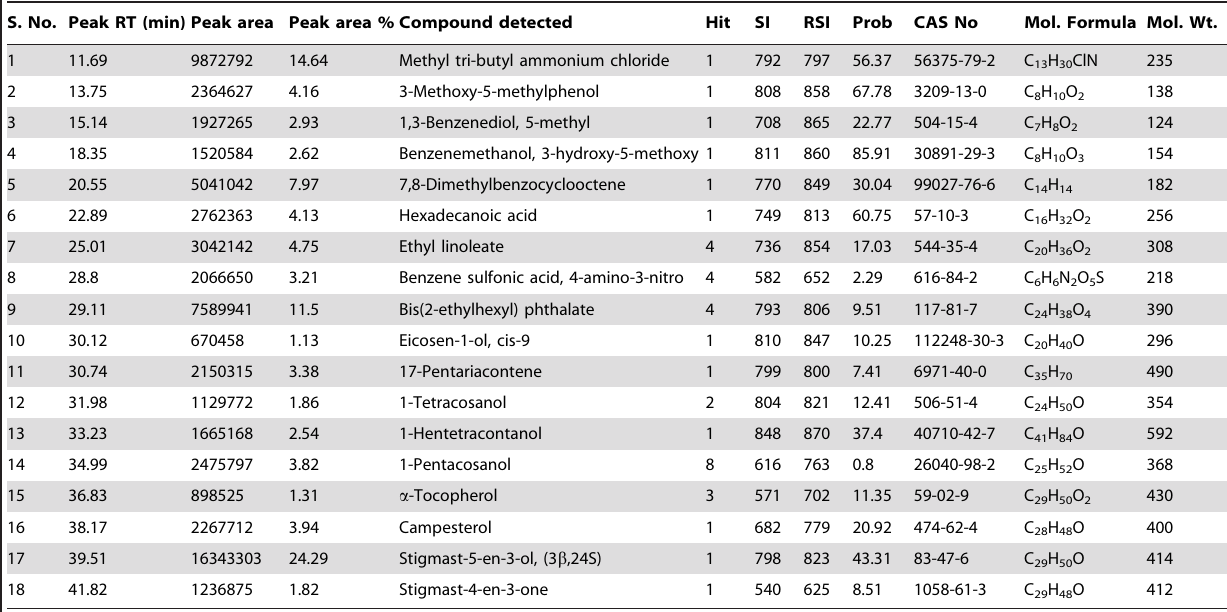
S. No. Peak RT (min) Peak area Peak area % Compound